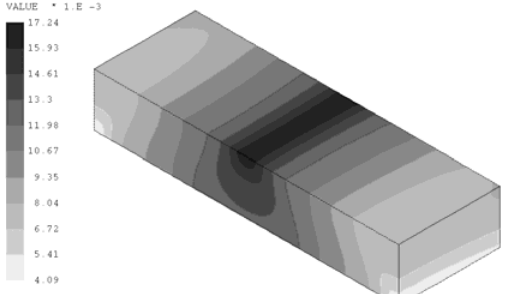
wich structures